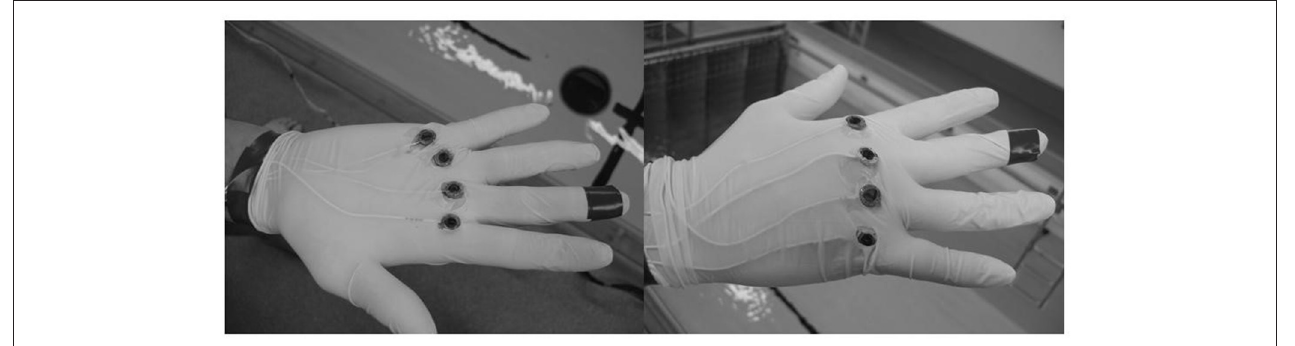
FIGURE 1 | Locations of the force sensors over the